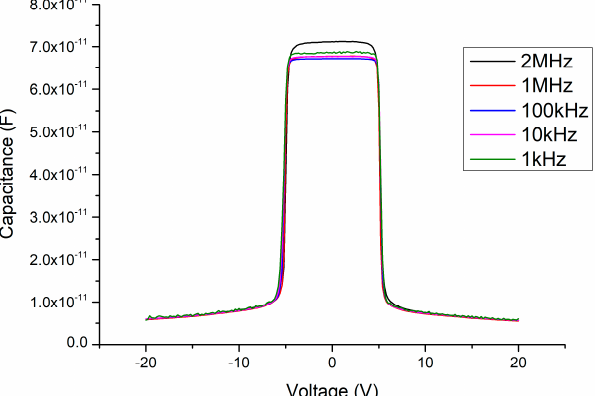
Figure 18. C–V measurement results of the MOSOM (with a 156 nm thick Ga 2 O 3 thin film) after 500 °C and 4 min of annealing.